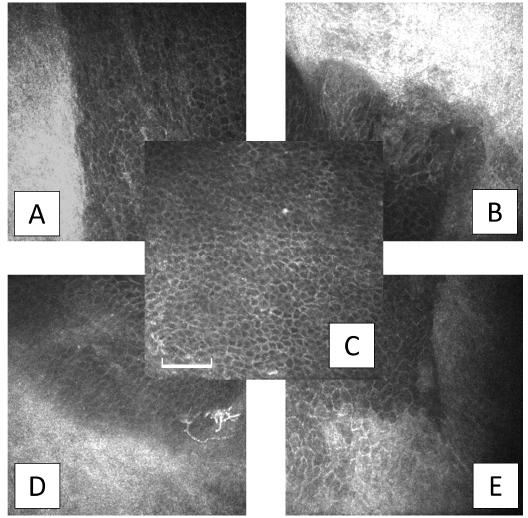
Figure 5. Central epithelium and transition zone at 6-month evaluation after Simple Limbal Epithelial Transplantation (SLET). ( A , B , D , E ) distinct epithelial transition zone in all four peripheral corneal sectors; corneal cells are well-defined, darker, and smaller than their conjunctival counterpart; ( C ) regular and mature basal corneal epithelium in the central cornea. (C denotes central, A temporal, B superior, D inferior, E nasal corneal sectors; Images are 400 × 400 µm, the bar is 100 µm).